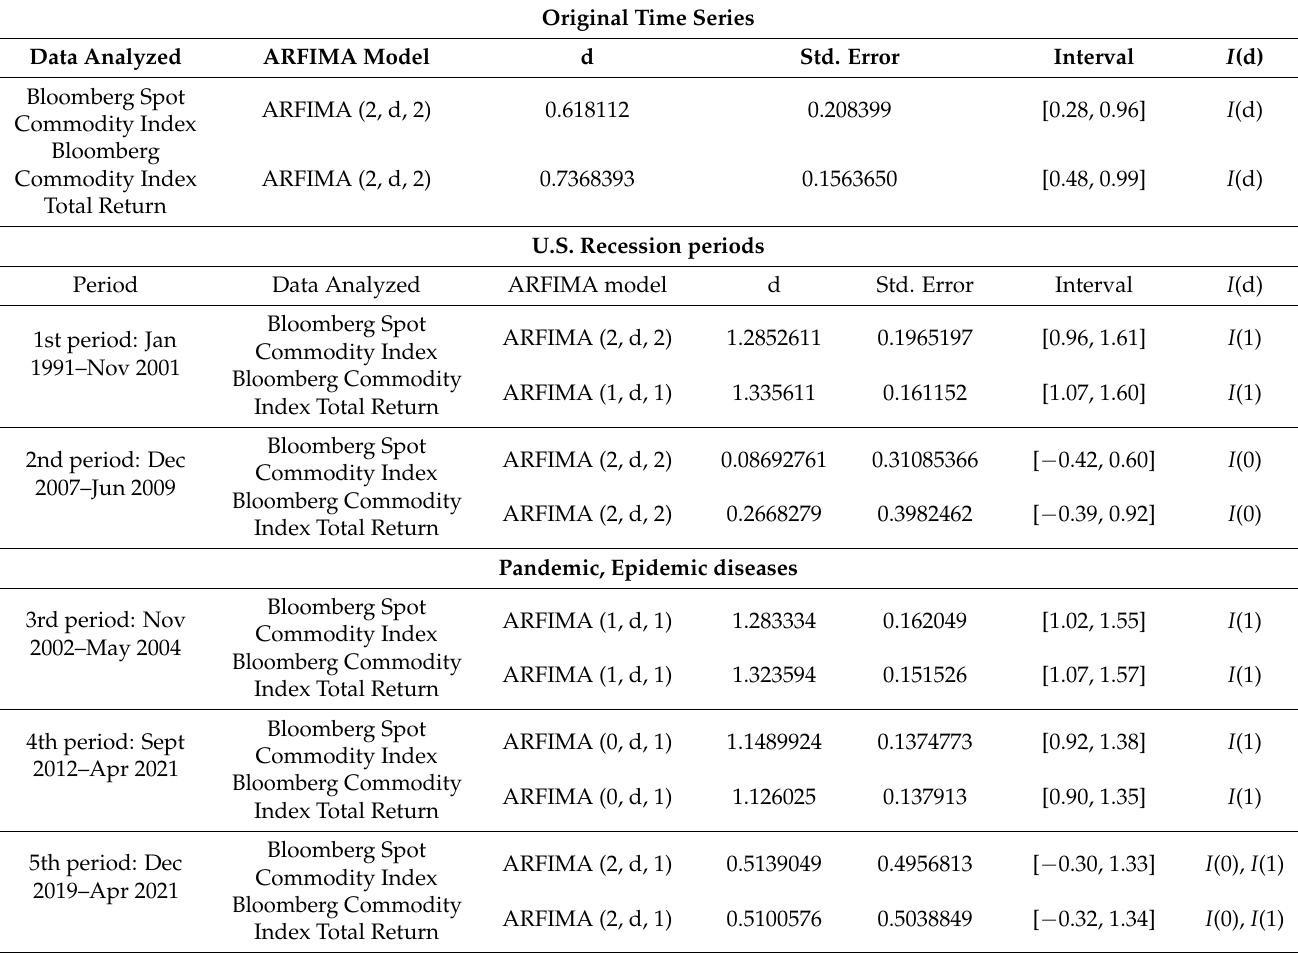
Table 3. Results of long memory